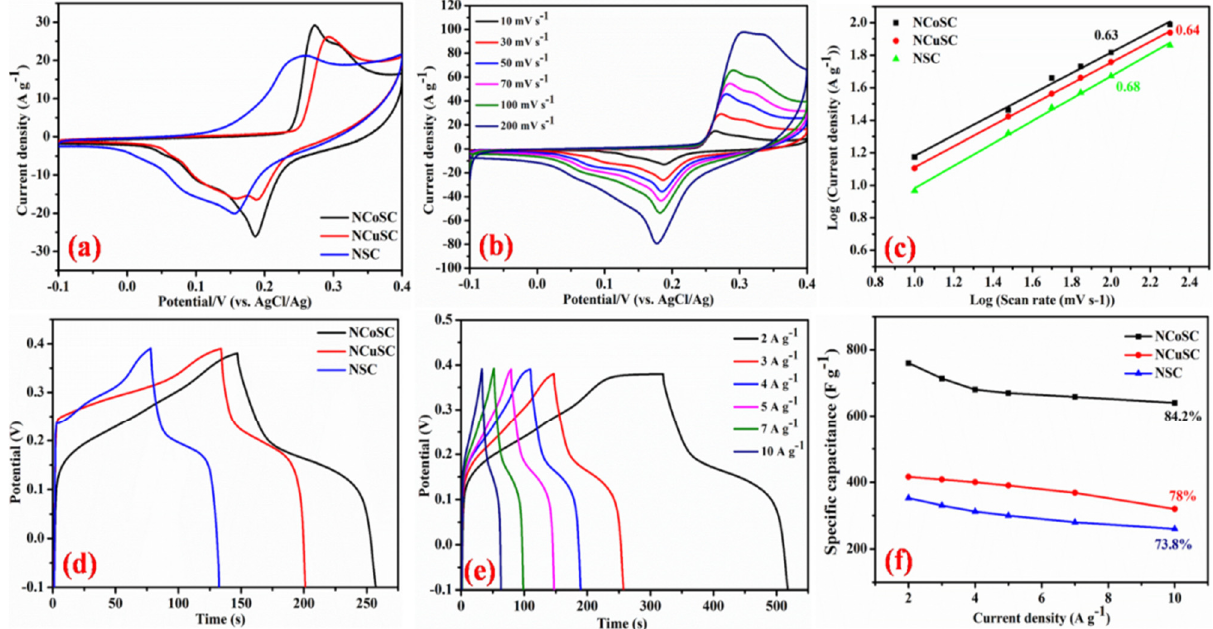
Figure 3. ( a ) Comparable CV curves of NSC, NCuSC, and NCoSC electrodes; ( b ) CV curves of NCoSC electrode at different scan rates; ( c ) Log (i) vs. Log (v) plots of NSC, NCuSC, and NCoSC electrodes; ( d ) comparable GCD plots of NSC, NCuSC, and NCoSC electrodes; ( e ) GCD profile of NCoSC electrode at different current density; ( f ) comparable specific capacitance vs. current density curves of NSC, NCuSC, and NCoSC electrodes.